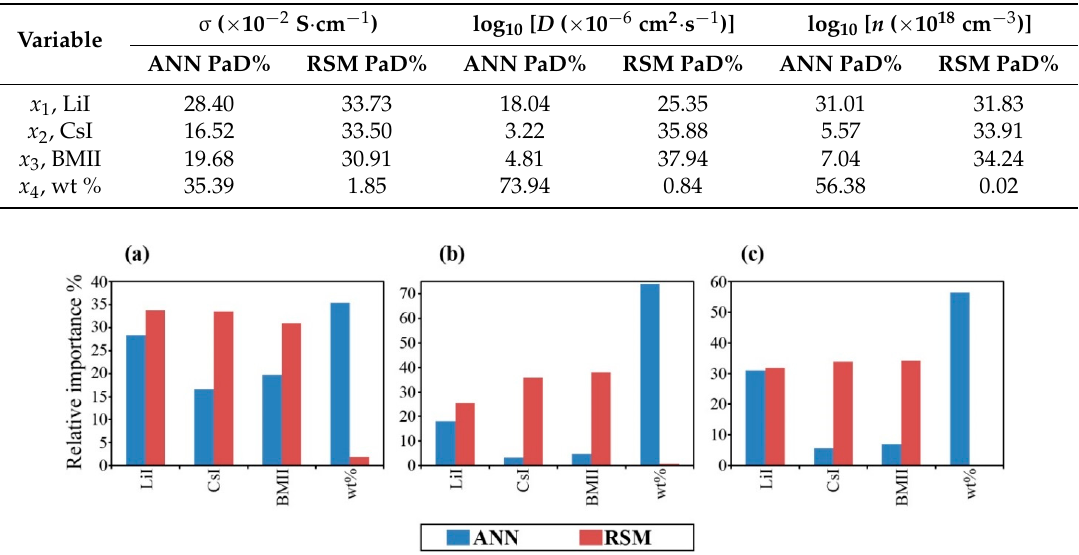
Table 3. PaD relative importance of individual input towards the output response properties of (a) σ